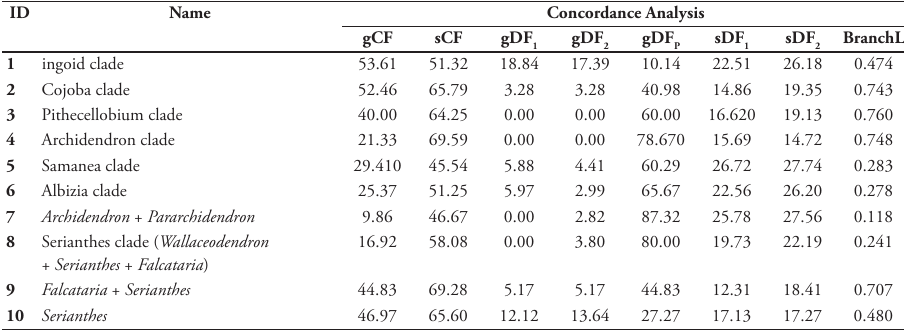
Table 4. Comparison of concordance, discordance factors and branch lengths calculated in IQ-TREE for individual nodes in the Mimosoid phylogeny.